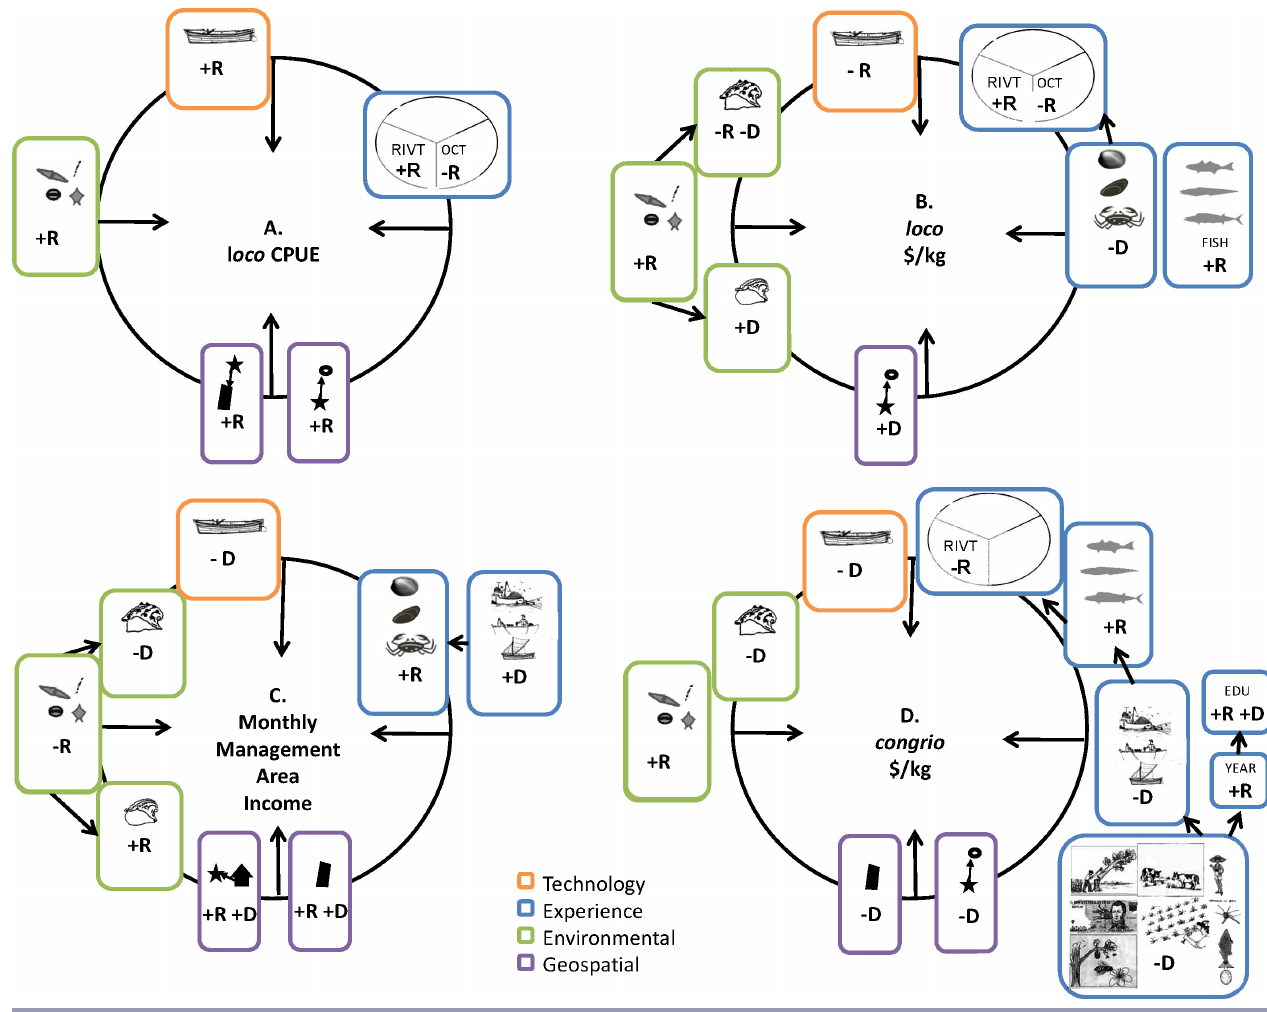
Fig. 3 . Significant causal factors identified in regression (positive influence [+R] and negative influence [-R]) and discriminate (positive influence [+D] and negative influence [-D]) analysis. Factors outlined in black were most influential in the (A) loco CPUE (geospatial); (B) loco price (environment); (C) management area income (environment); and (D) congrio price